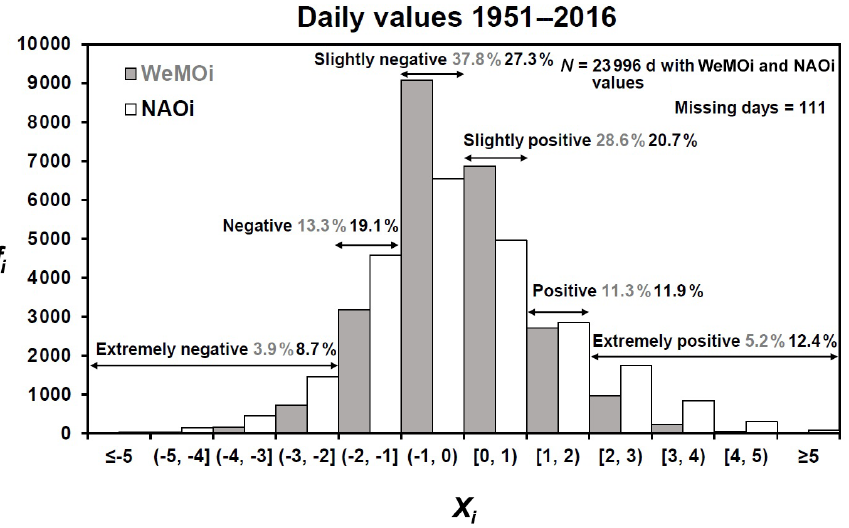
Figure 4. Frequency histogram of all daily WeMO index (WeMOi) values and daily North Atlantic Oscillation index (NAOi) values during the 1951–2016 study